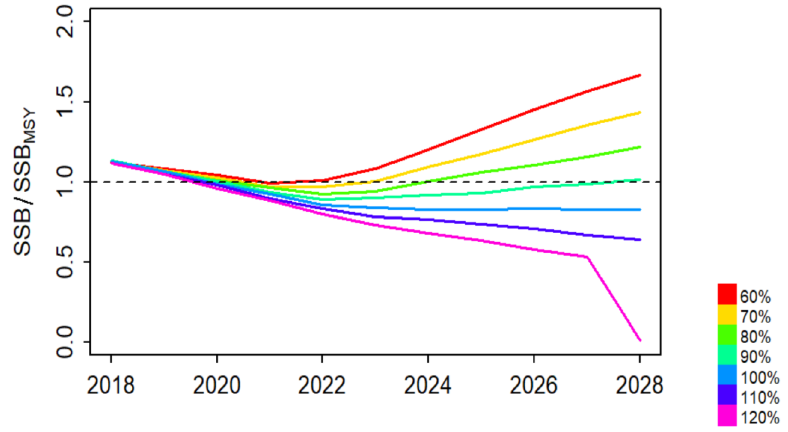
Figure 5. Trajectories of the median stock status between 2019 and 2028. Reproduced from [37], with permission from Indian Ocean Tuna Commission, 2022. Table 2. Key management quantities from the 2016 SS3 assessment. Reproduced from [36], with permission from Indian Ocean Tuna Commission, 2022.